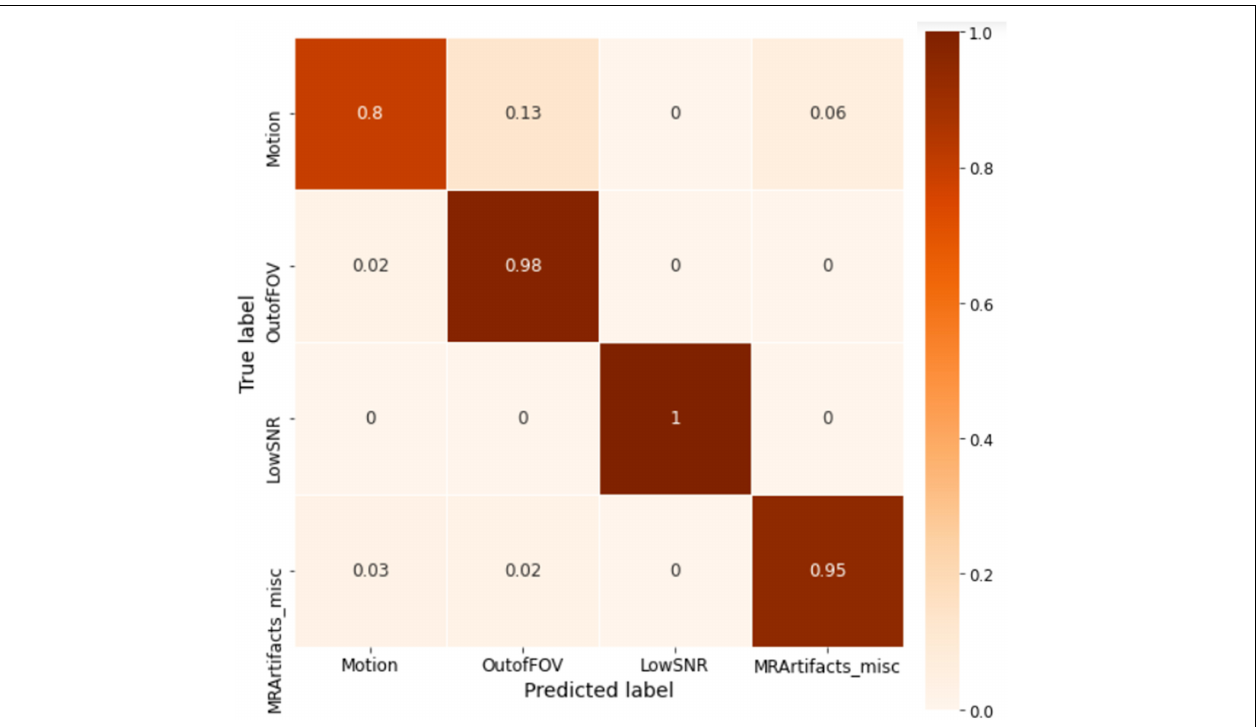
FIGURE 10 | The slab-level confusion matrix for the HBN test set. The matrix is mostly diagonal with some misclassifications in the motion class.